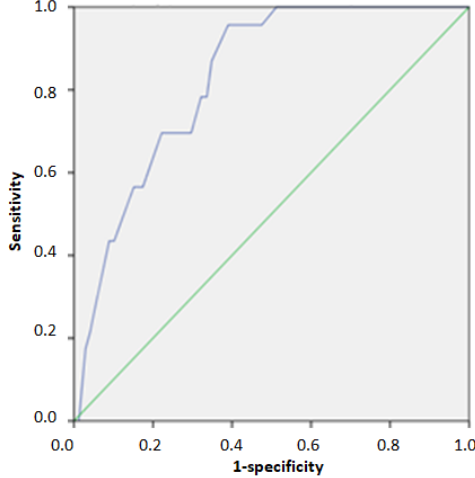
Figure 2. ROC Curve for identifying individuals above the 95th percentile of HOMA-IR.